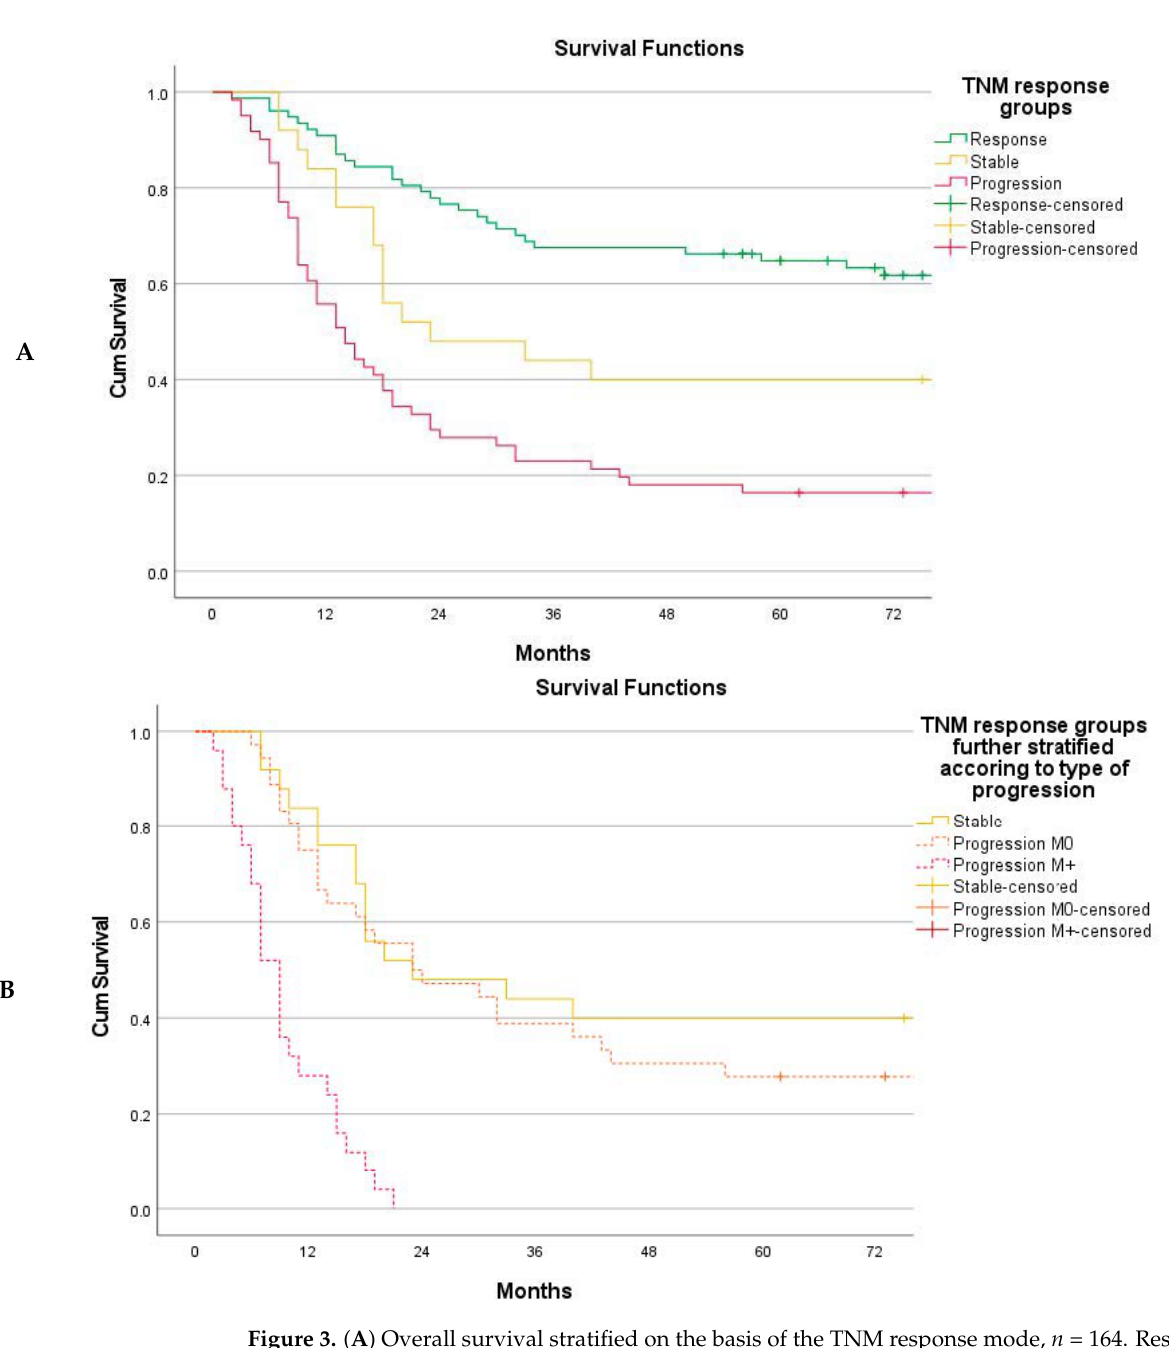
6 of 15 Figure 2. Cross-tabulation of the CT stage at diagnosis (rTNM) vs. the de fi nitive pathological stage (ypTNM), n = 164. Green: response, downstaged ( n = 78); yellow: stable disease ( n = 25); red: pro- gression, upstaged ( n = 61). The TNM response mode did achieve the objective of stratifying patients into groups